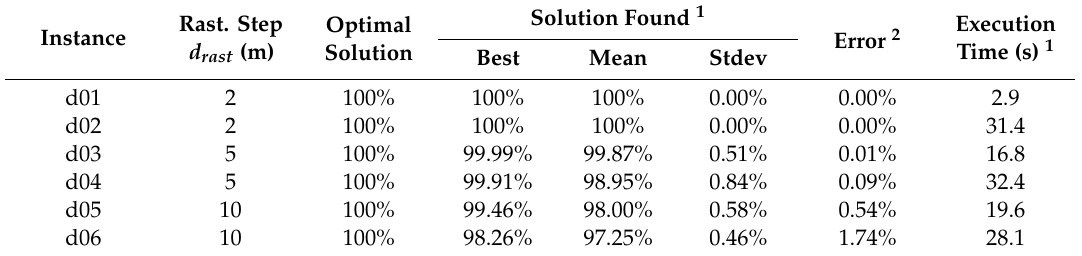
Table 4. Results for benchmark problems achieved by the continuous version of the